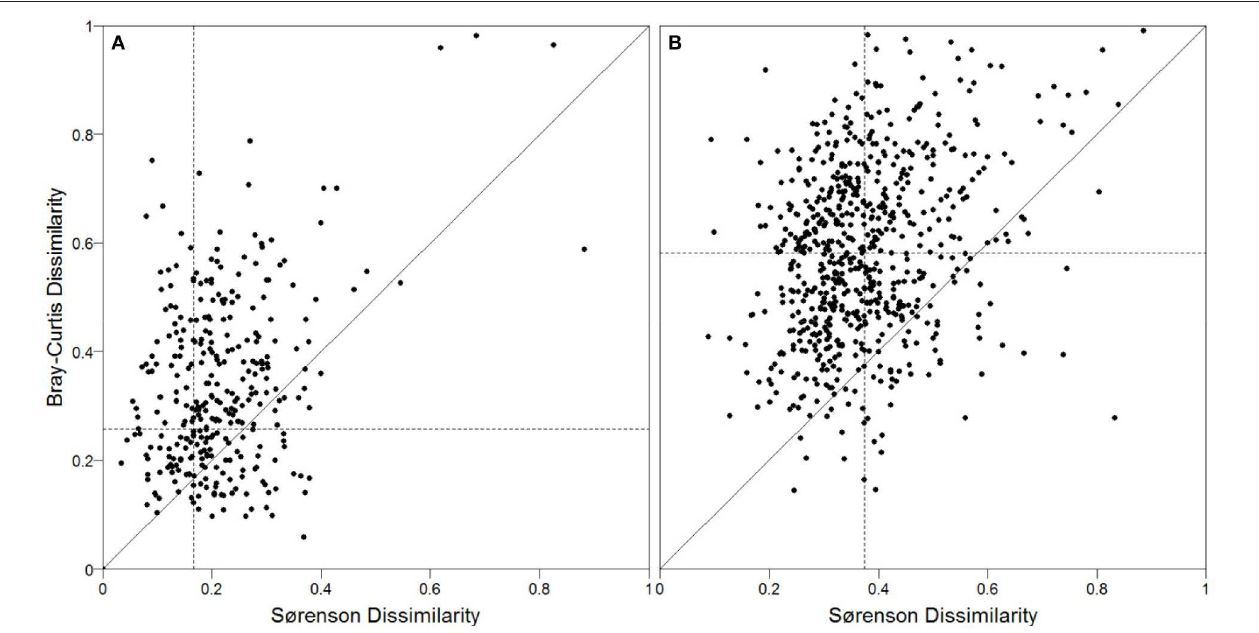
FIGURE 1 | Dissimilarity between replicate samples (same location and time) based on presence/absence data (Sørensen), and count data (Bray-Curtis) of morphologically identified macroinvertebrate families from (A) 417 CABIN (Canadian Aquatic Biomonitoring Network; ECCC, 2018) surveys (total n = 1,656, mean richness = 16 ± 4.8), and (B) 787 surveys from the STAR-AQEM dataset (total n = 1,673) from 14 European countries (mean richness = 51 ± 18.4; Furse et al., 2006; Schmidt-Kloiber et al., 2014